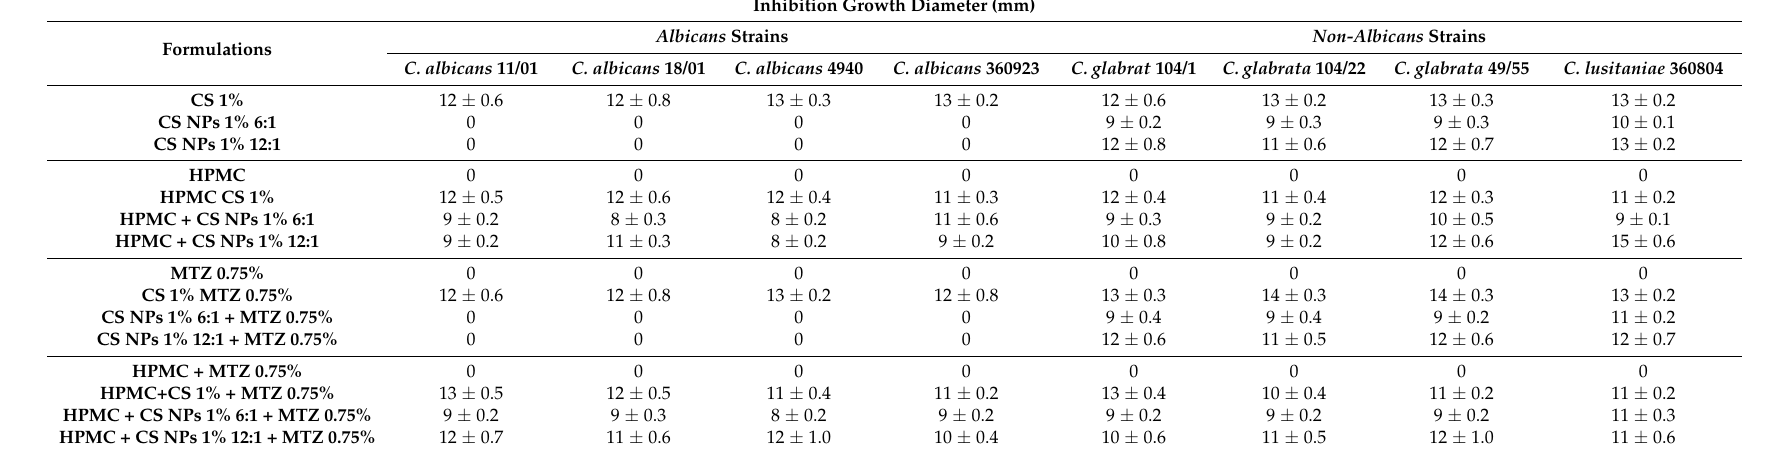
Table 2. Antimicrobial activity of HPMC/CS hydrogels and relative controls (CS dispersions), assessed by the agar well diffusion method (AWDM) against eight strains of Candida spp. obtained from vaginal swabs. The data represent the growth inhibition diameter (in mm) of each tested sample. Values are reported as the mean ± SD of two